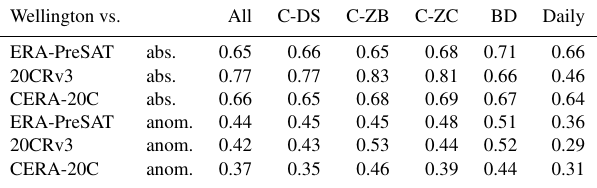
Table 3. Correlation coefficients (before and after deseasonalising) between total column ozone at Wellington and in other data sets (1951–1959) for different wavelengths and observation modes (the table relates to the case of Bass–Paur coefficient; results are almost indistinguishable for the adjusted coefficients). Wellington vs.